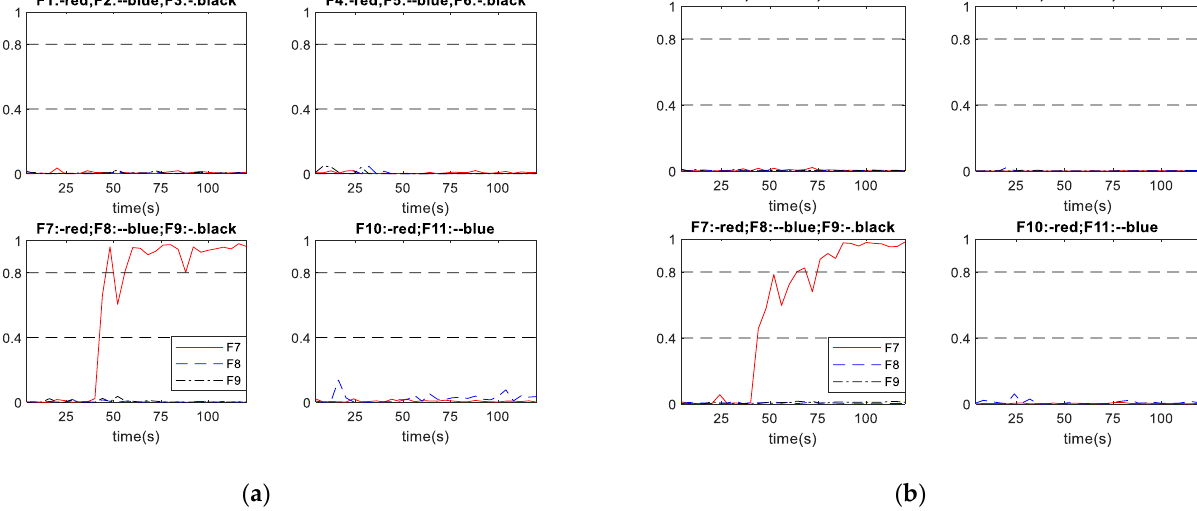
2, with the fault relative magnitude being 1.67%. In Figure 8 and the subsequent diagnosis output plots, F1 to F11 represent the neural network outputs corresponding to Fault No. 1 to No. 11 listed in Table 1, respectively. The upper dash-dotted lines indicate the diag- nosis threshold (0.8) while the lower dash-dotted lines indicate the advance warning threshold (0.4). Figure 8a shows that scheme A successfully diagnosed the fault at 20 s after the fault being initiated. Figure 8b shows that the outputs from scheme B responded quickly, when the abnormal condition occurred but with fluctuations. Eventually the fault was diagnosed at 32 s after the fault being initiated. The output curve then still oscillates with a certain magnitude over the 0.8. It can be seen that the proposed scheme A diag- nosed the fault 12 s earlier than scheme B and the output curve is steadier than scheme B. Figure 9 shows the performance of schemes A and B in diagnosing abrupt fault No. 7, with the fault relative magnitude being 27.86%. As in the previous case, the outputs in scheme A have isolated points exceeding the diagnosis threshold (0.8) before the oscilla- tion stabilized. Figure 9a shows that scheme A successfully diagnosed the fault at 16 s after the fault being initiated. Figure 9b shows that scheme B successfully diagnosed the fault at 36 s after fault being initiated. The diagnosis time of scheme A for this fault is 20 s shorter than that of scheme B. 4.3. Performance under Incipient Faults The proposed scheme A and the conventional schemes B and C are applied to three groups of incipient faults given by Table 5 to compare fault diagnosis results. All of the incipient faults were initiated at 0 s. Table 12 indicates that all diagnosis systems success- fully diagnosed all the considered incipient faults. In terms of the diagnosis speed, the pro- posed diagnosis scheme A diagnosed the incipient faults 13.82 s and 5.09 s earlier on average than schemes B and C, respectively . Table 13 gives the FDR values for the considered incip- ient faults of the three schemes. In can be seen that the proposed scheme A gives overall higher FDR than schemes B and C. Table 13 also indicates that the FDR is higher when the fault developing speed is higher as a faster developing fault is generally easier to detect and diagnosis than a slower developing fault. As with the abrupt fault cases, there are no incor- rect diagnosis cases and all the undetected samples are during the early stages of the faults when their magnitudes are low. Thus, MDR can be simply worked out as 1-FDR and are not shown here. The following figures show three sets of diagnosis outputs in incipient faults as examples to show the good performance of the proposed scheme.